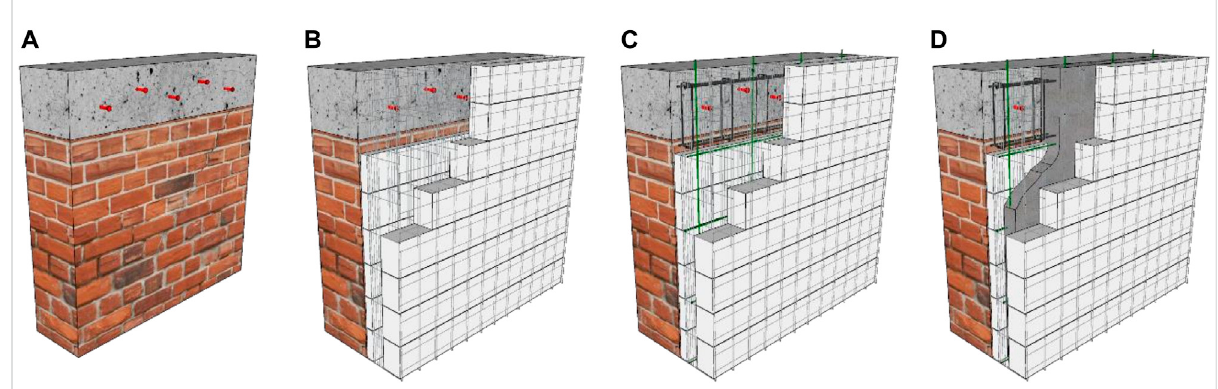
FIGURE 4 Construction phases of the integrated solution based on RC shell structures: (A) anchoring installation; (B) disposition of insulation panels; (C) placing of the steel reinforcement for RC elements; (D) concrete casting (adapted from (Pertile et al., 2021).